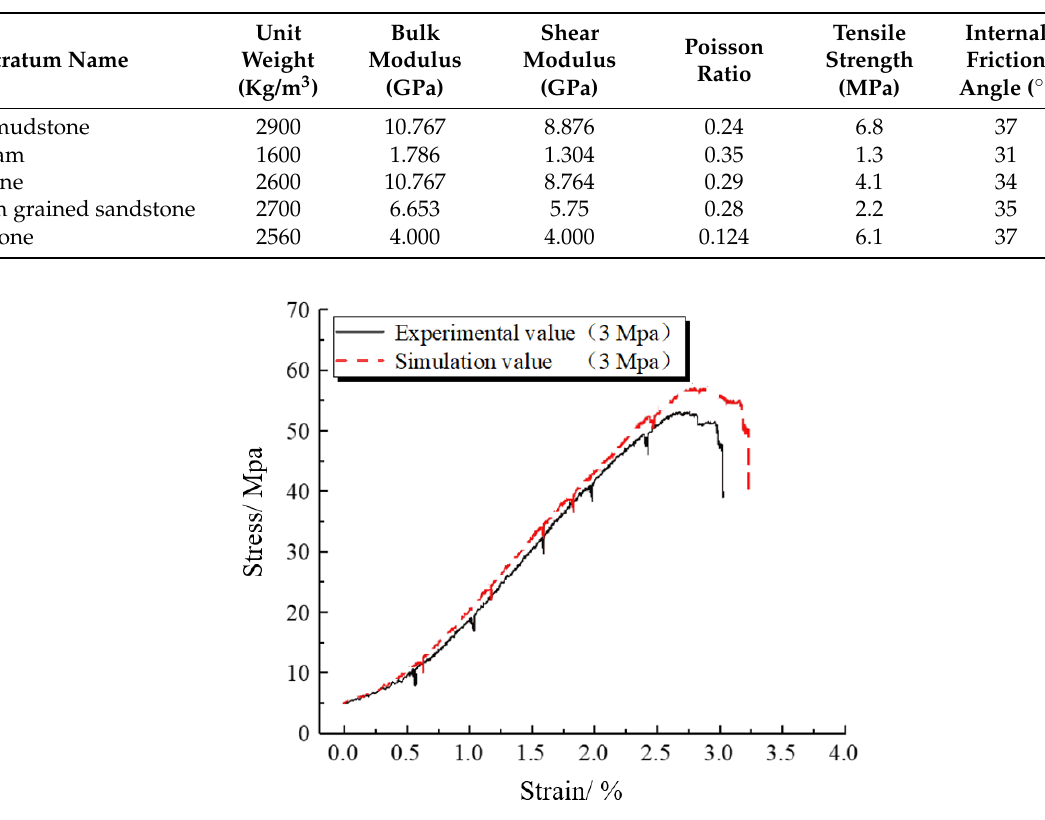
Figure 11. Comparison of stress–strain curves between laboratory test and simulation test. To sum up, the strength values obtained by using the meso-parameters in Table 1 are close to the laboratory test values. It shows that the meso-parameters in Table 1 can reflect the macro-mechanical characteristics of the coal seam, roof, floor, and overlying strata, and can be used for subsequent corresponding simulation